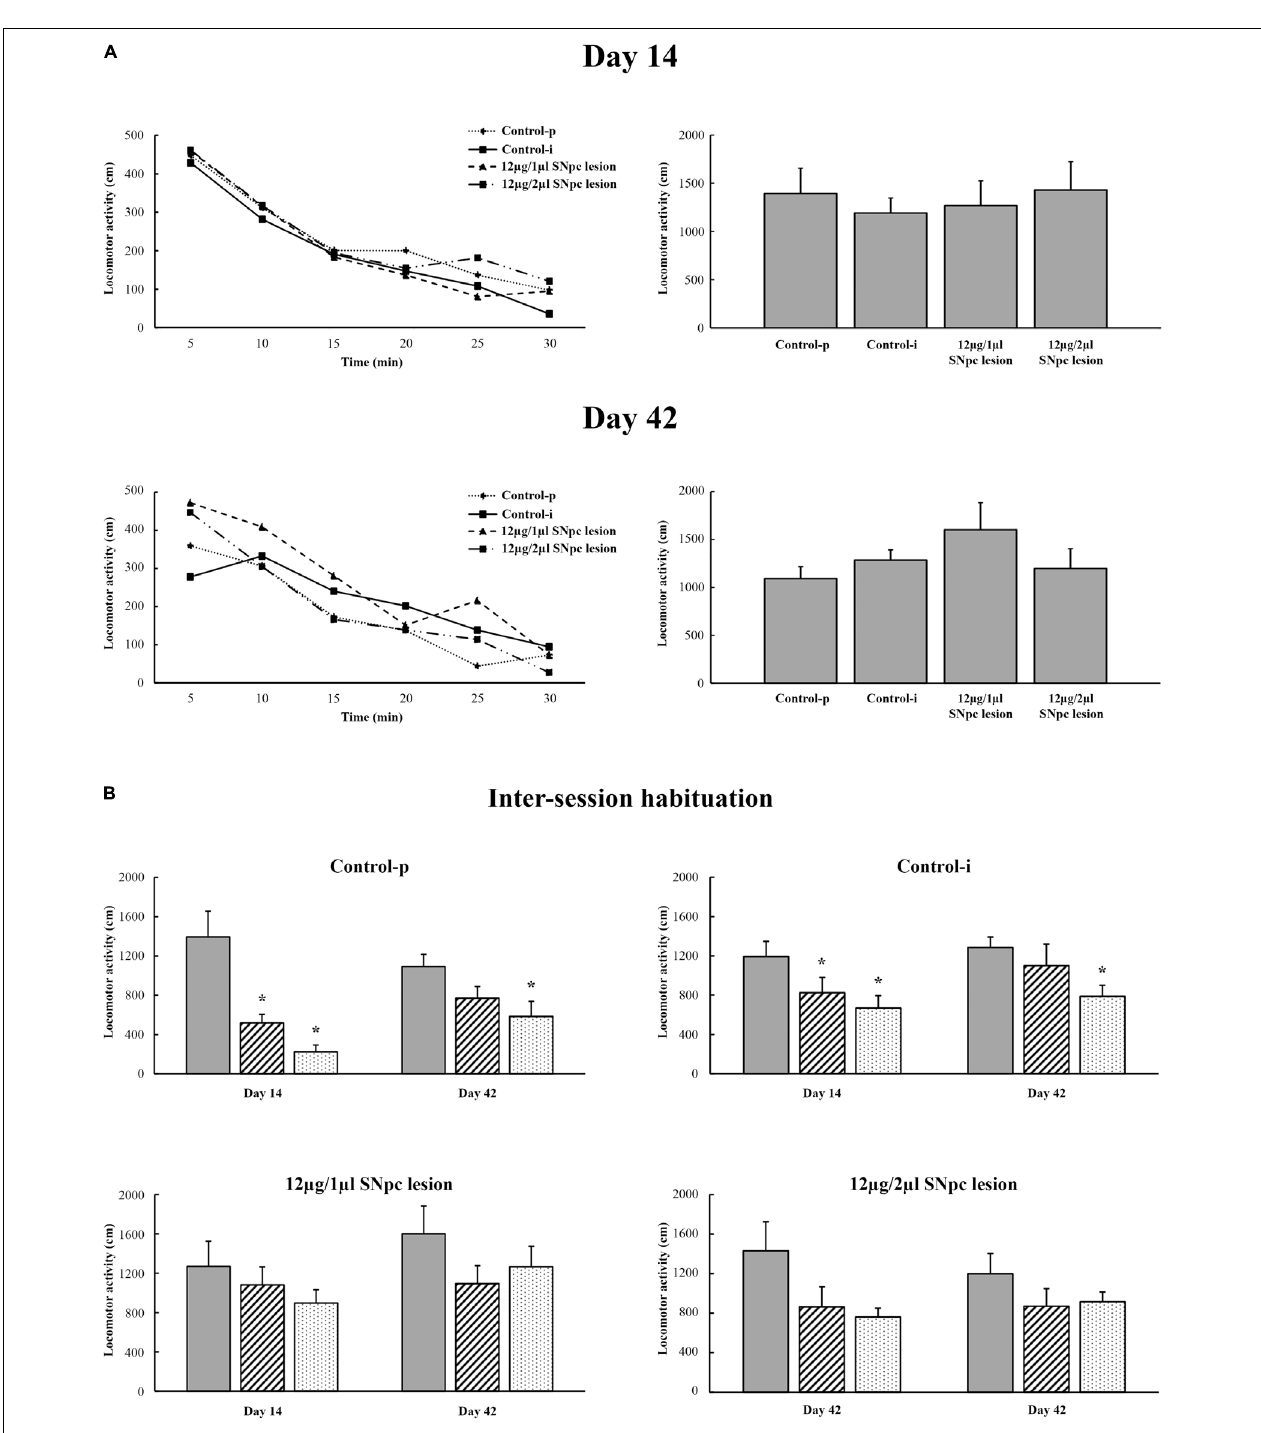
FIGURE 7 | Spontaneous locomotor activity following the unilateral SNpc lesion (A) and during inter-session habituation over three consequtive days at each time point (B) with respect to the physiological controls (Control-p) and implanted controls (Control-i), expressed as the means for 5 min intervals (left panels) or as the means ± SE for 30 min intervals (right panels) at 14 and at 42 days following the SNpc lesion. The time-dependent profiles of locomotor activity (left panels) were similar for all the experimental groups as well as for the entire registration period (right panels). There was no alteration in the basal locomotor activity. Importantly, in contrast to the physiological controls (Control-p; n = 6) and the implanted controls (Control-i; n = 7), the time-dependent profiles of locomotor activity during inter-session habituation in the unilaterally SNpc lesioned rats (12 µ g/1 µ l SNpc lesion, n = 6; and 12 µ g/2 µ l SNpc lesion, n = 6), and over three consecutive days, only indicated impaired spatial memory abilities from the onset of SNpc dopaminergic neuronal loss. Stars indicate the statistically significant mean values at p ≤ 0.05 obtained using the Mann–Whitney U tests.